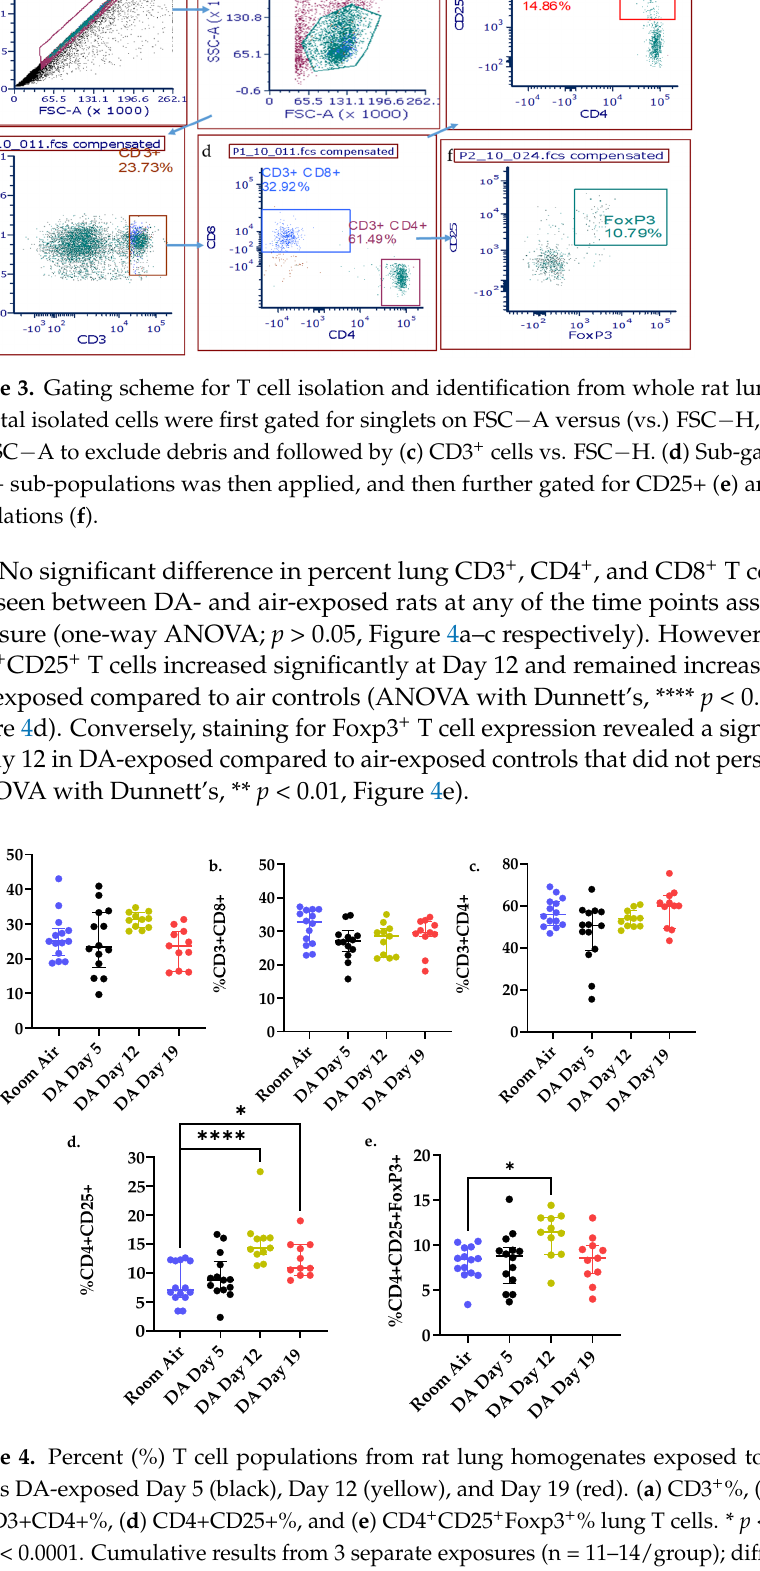
creased at Days 12 and 19 in DA-exposed animals compared to room air controls (* p < 0.05, Figure 5b). The increase in BALF IL-17a expression coincided temporally with the persistence of lung CD4 + CD25 + T cells (Figure 4d), decrease in lung CD4 + CD25 + Foxp3 + T cells (Figure 4e) and increase in BALF albumin after DA exposure (Figure 5b).